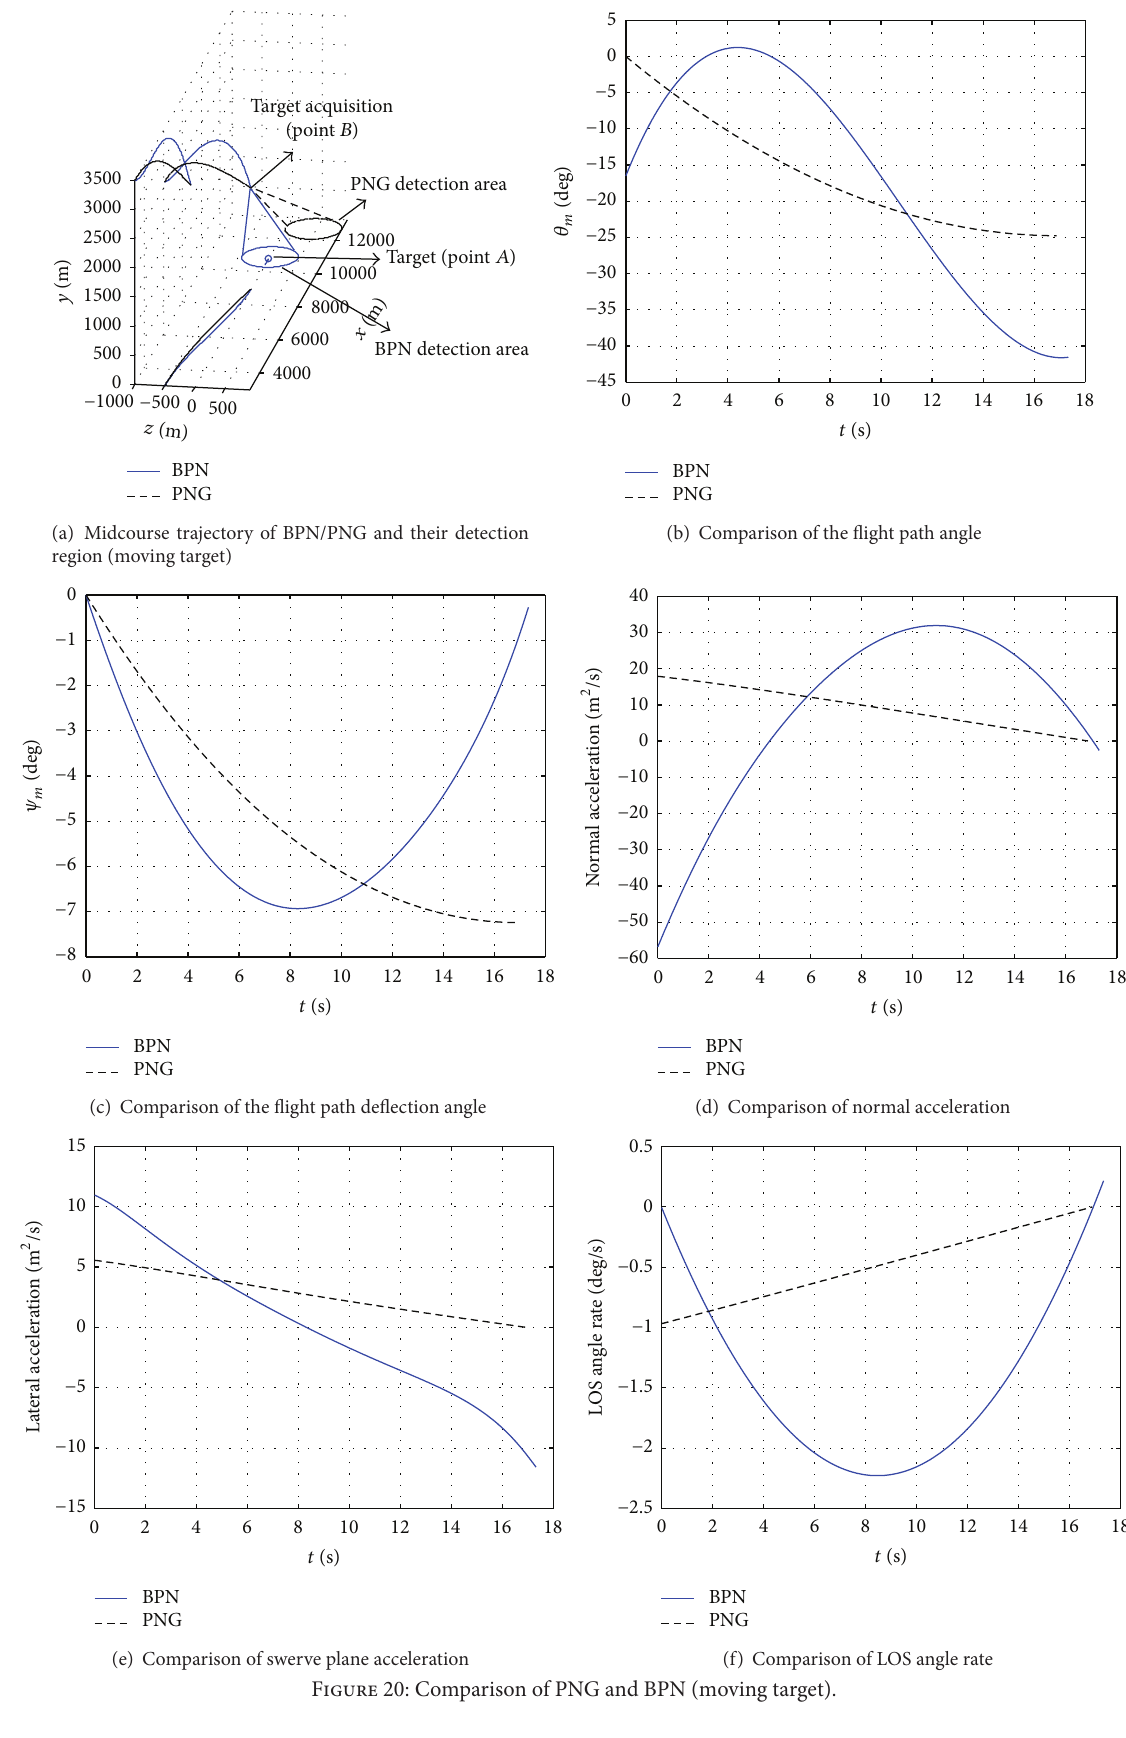
Figure 20: Comparison of PNG and BPN (moving